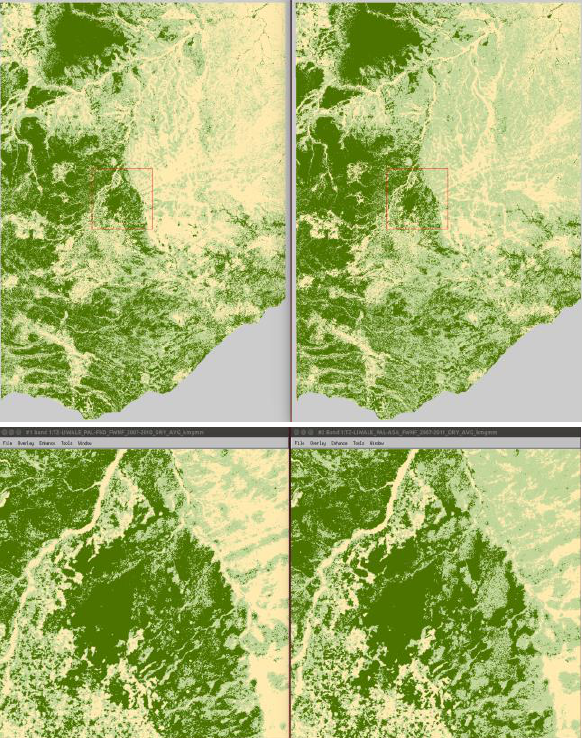
Figure 4. Single sensor classification with ALOS Palsar (left) versus multi-sensor classification using ALOS Palsar and Envisat ASAR (right). Lower panels are enlargements of the red rectangles. Forest in dark green, woodland in light green, and non-forest in beige.